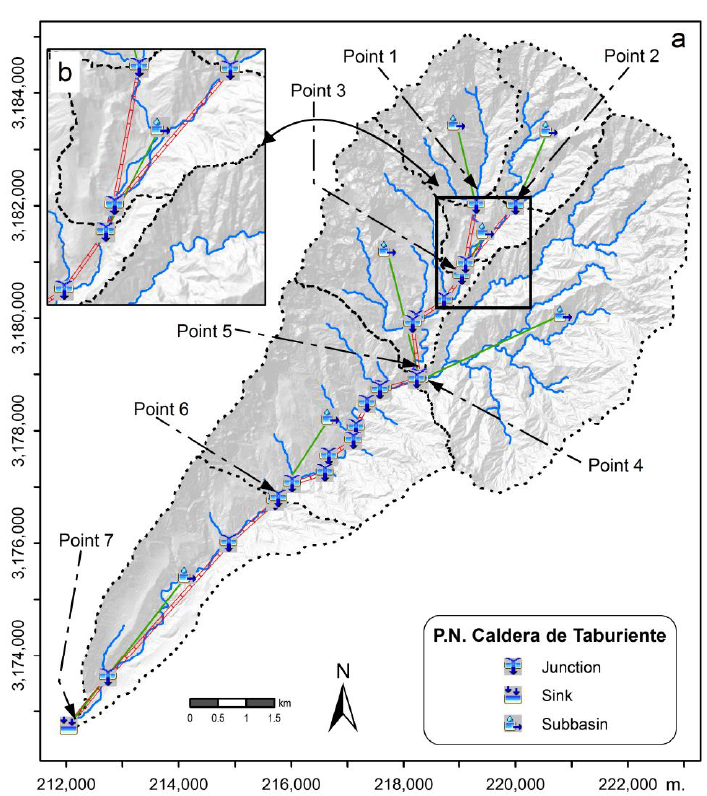
Figure 3. Rainfall-runoff model (HEC-HMS) developed for Taburiente river basin, with ( a ) main features: sub-basins, drainage network, junctions, propagation reach, etc.; ( b ) detailed view of the model in the “Playa de Taburiente” area.